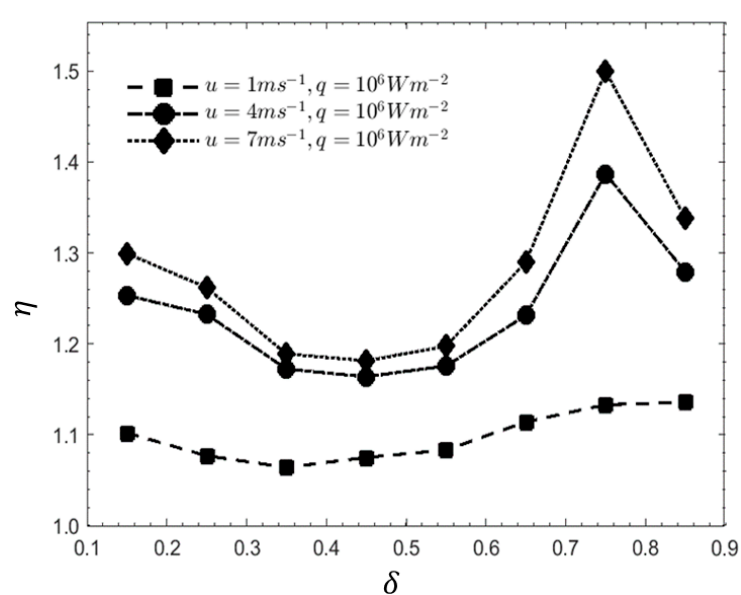
Figure 11. 𝜂 against 𝛿 .